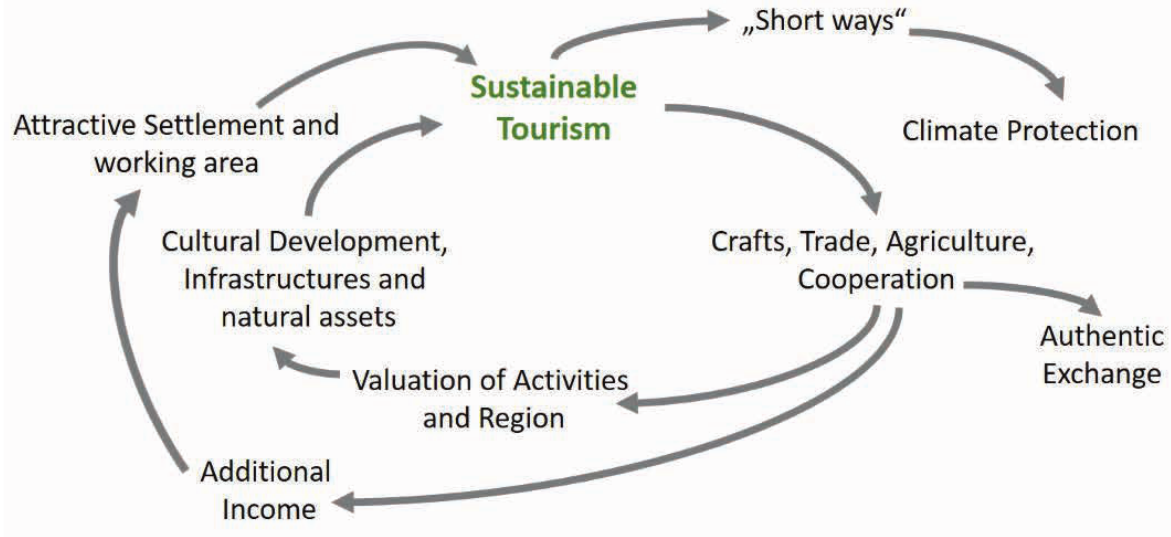
Figure 2: Influences on and effects of Sustainable Tourism framework Source: Regionalplanungsgemeinschaft Pielachtal 2008, 19 (translated by